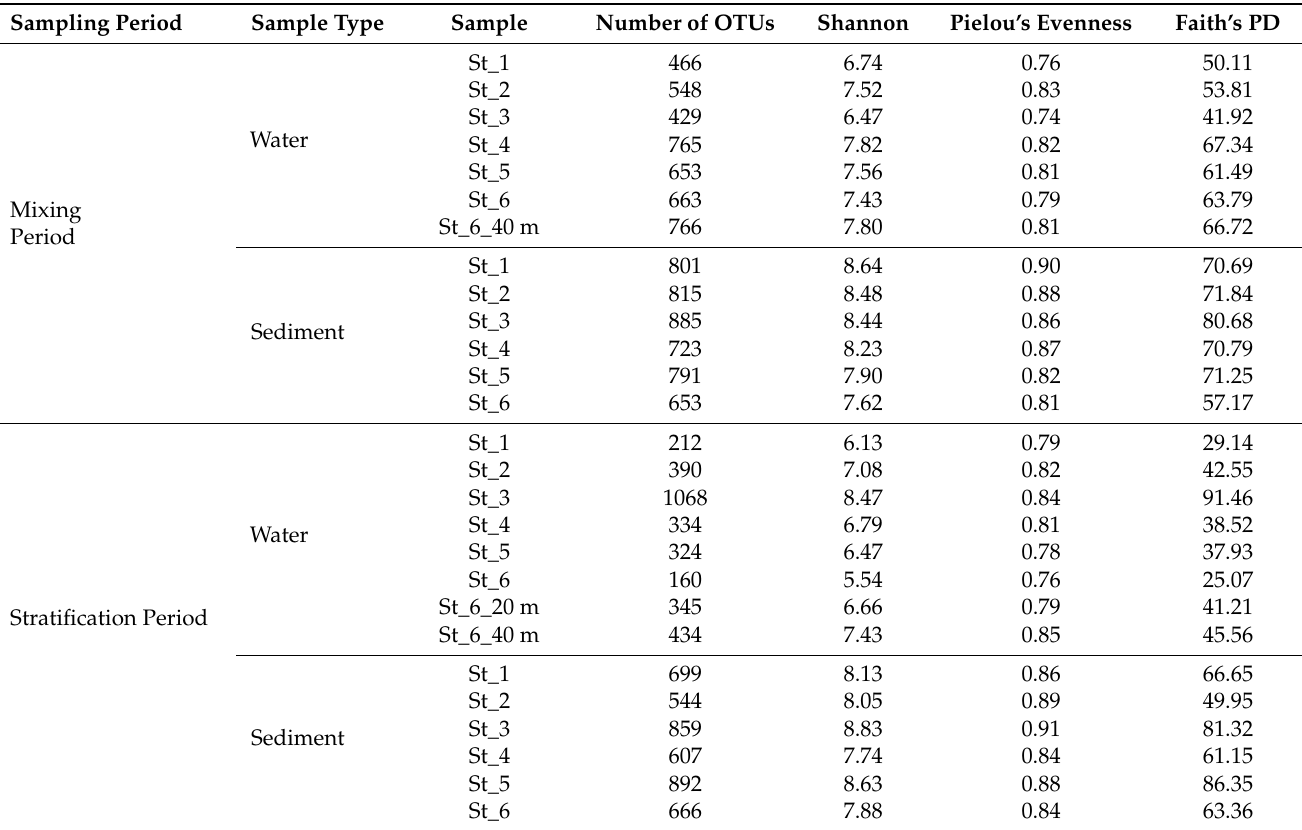
Table 2. Summary of the alpha diversity of the bacterial communities in water and sediment